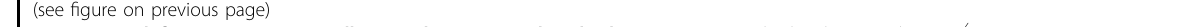
Fig. 2 DRD5 de fi ciency in immune cells exacerbates DSS-induced colitis. A , B Age-matched male WT and DRD5 − / − mice ( n = 9 mice per group) were given 2.5% DSS in their drinking water for 6 days and distilled water for three additional days before sacri fi ce. Weight changes ( A ) and disease activity index (DAI) ( B ) were monitored daily. C Gross morphology images of colons and colon lengths of WT and DRD5 − / − mice on day 9 after DSS treatment. D Representative H&E-stained colonic sections and histology scores of WT and DRD5 − / − mice sampled on day 9 after DSS treatment. Scale bars, 4×, 500 μ m; 20×, 200 μ m. E The concentration of TNF- α , IL-6, and CCL2 in the serum of WT and DRD5 − / − mice were measured by ELISA. F , G Weight changes ( F ) and disease activity index (DAI) ( G ) after DSS-induced colitis in WT and DRD5 − / − mice ( n = 5 mice per group) adoptively transferred with WT or DRD5 − / − bone marrow cells. H Gross morphology images of colons and colon lengths of WT and DRD5 − / − mice adoptively transferred with WT or DRD5 − / − bone marrow cells on day 9 after DSS treatment. I Representative H&E staining of colonic sections and histology scores of WT and DRD5 − / − mice adoptively transferred with WT or DRD5 − / − bone marrow cells on day 9 after DSS treatment. Scale bars, 4×, 500 μ m; 20×, 200 μ m. J The concentration of TNF- α , IL-6, and CCL2 in the serum of WT and DRD5 − / − mice ( n = 5 mice per group) adoptively transferred with WT or DRD5 − / − bone marrow cells after DSS treatment. Data are pooled from three independent experiments. Error bars show means ± SEM. * P < 0.05; ** P < 0.01; *** P < 0.001. multiple unpaired t -tests for ( A , B , F , G ) and two-tailed unpaired student ’ s t -test for ( C – E ). One-way ANOVA with Sidak ’ s multiple comparisons test for ( H – J